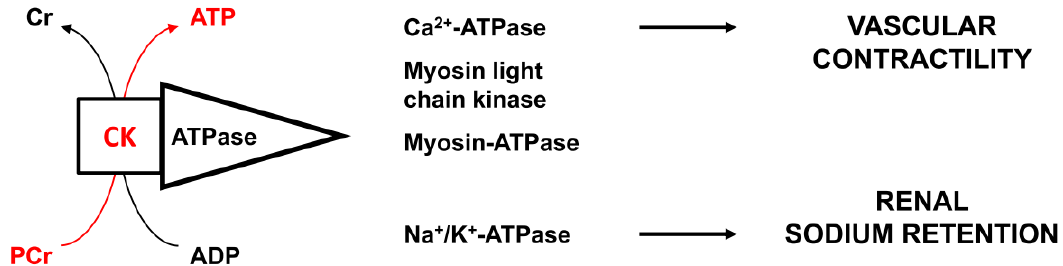
Figure 1. Creatine kinase and pressor responses. This figure depicts the proposed pathophysiology of high blood pressure with high creatine kinase (CK). CK is tightly bound near ATPases, such as calcium, sodium/potassium, and myosin ATPase, where the enzyme rapidly buffers the ADP generated by these ATPases into ATP, utilizing phosphocreatine. Thus, greater CK activity near these ATPases is thought to promote vascular contractility and the ability to retain sodium [5,6]. This places the individual with high CK activity at a greater risk to develop hypertension, with greater resistance against blood pressure- lowering therapy